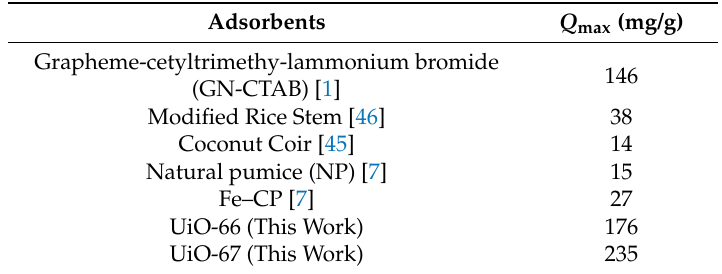
Table 4. The comparison of the UiOs’ adsorption of AO7 with the other reported adsorbents.